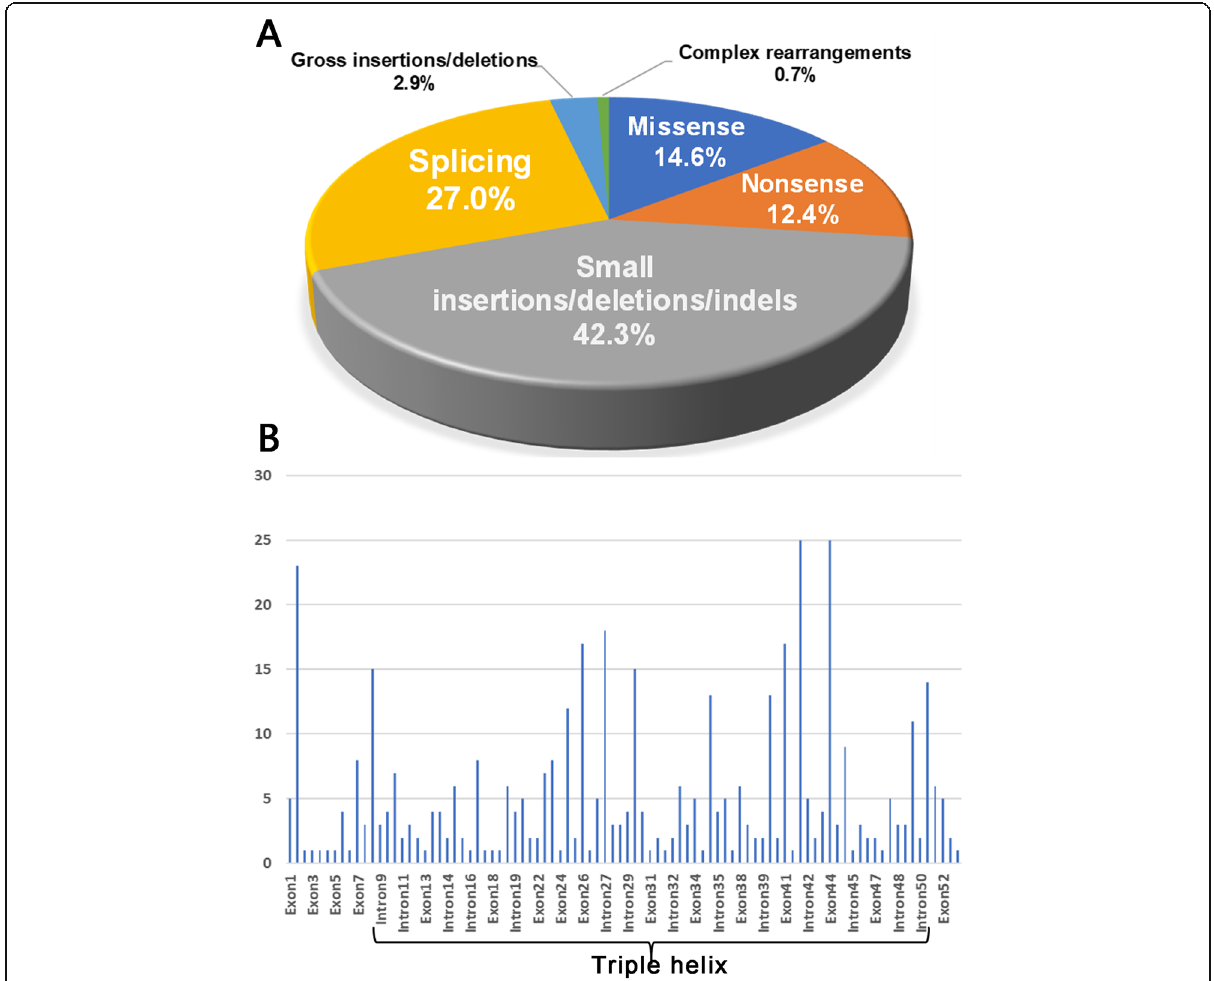
Fig. 2 The distribution of variants in the COL2A1 gene. a The distribution of mutation types. b The distribution of variants in different